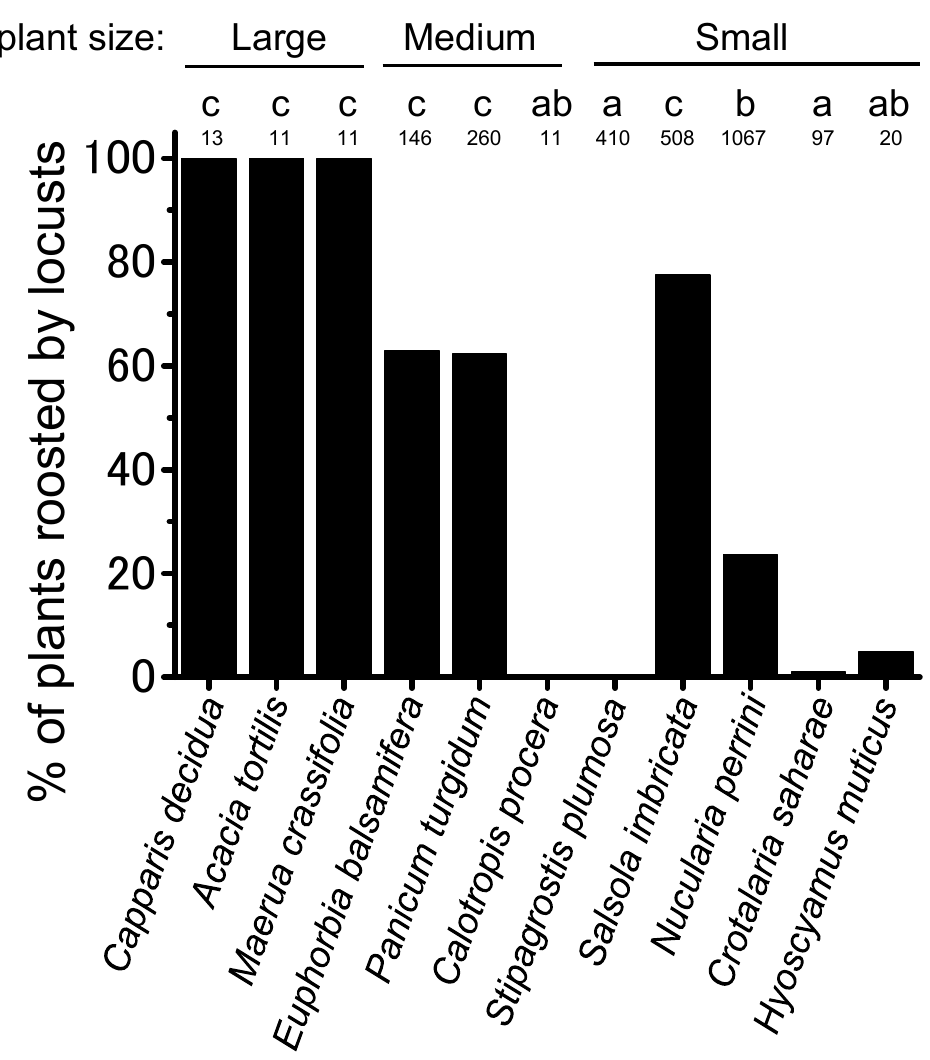
Figure 2. Percentage of plants from 11 plant species roosted by swarms of Schistocerca gregaria at four survey sites at night. Numbers above bars indicate sample sizes. Di ff erent letters above bars indicate significant di ff erences at p < 0.00091 (post hoc Fisher’s exact test after Bonferroni